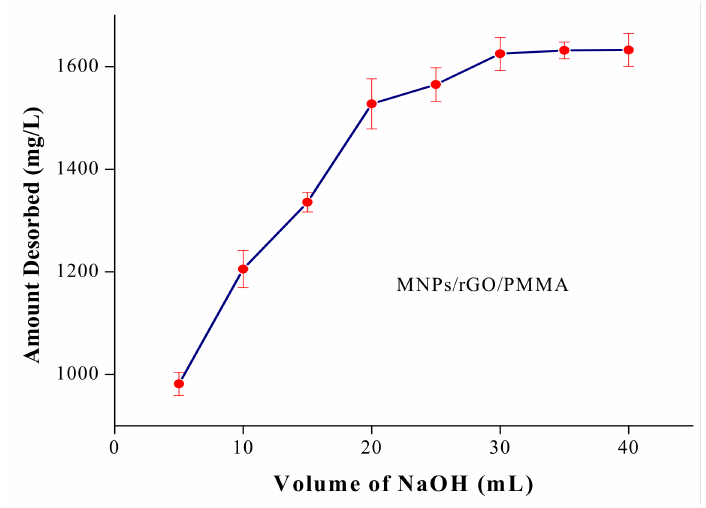
Figure 8. Effect of eluent volume on % recovery of Cr(VI) from MNPs/rGO/PMMA composite.